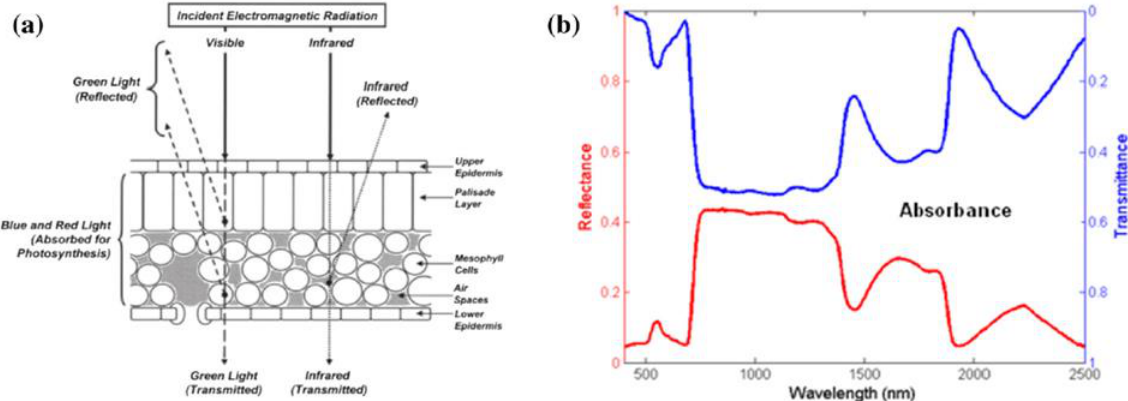
Figure 1. ( a ) Influence of electromagnetic spectrum based on the structure of a typical plant leaf (extracted from [4], ( b ) Spectral reflectance, absorbance and transmittance of a typical plant leaf (extracted from [5]).